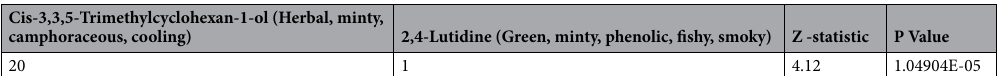
Cis-3,3,5-Trimethylcyclohexan-1-ol (Herbal, minty, camphoraceous,